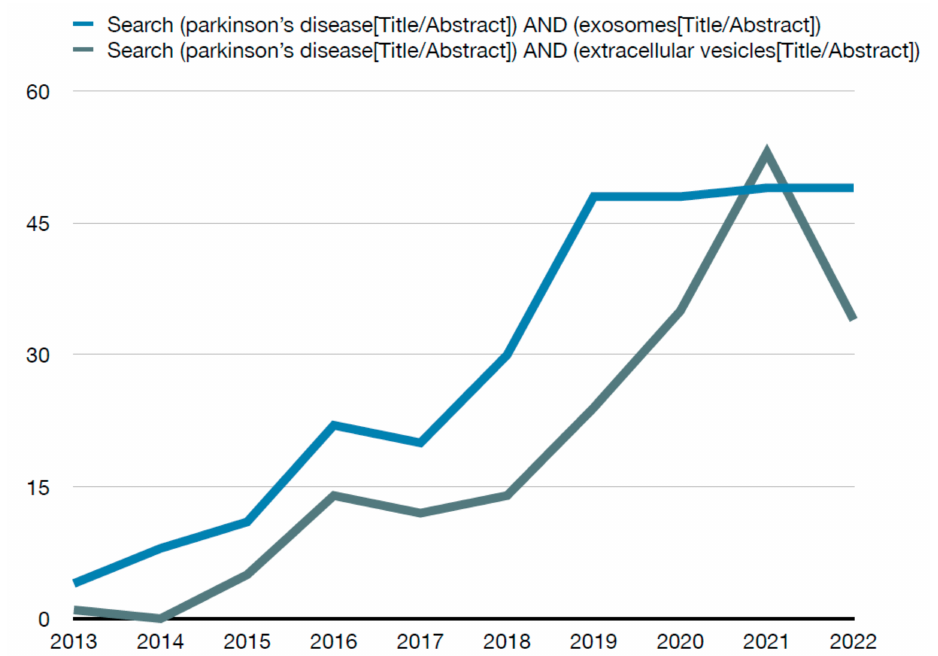
Figure 2. Number of PubMed results per year for the search method.